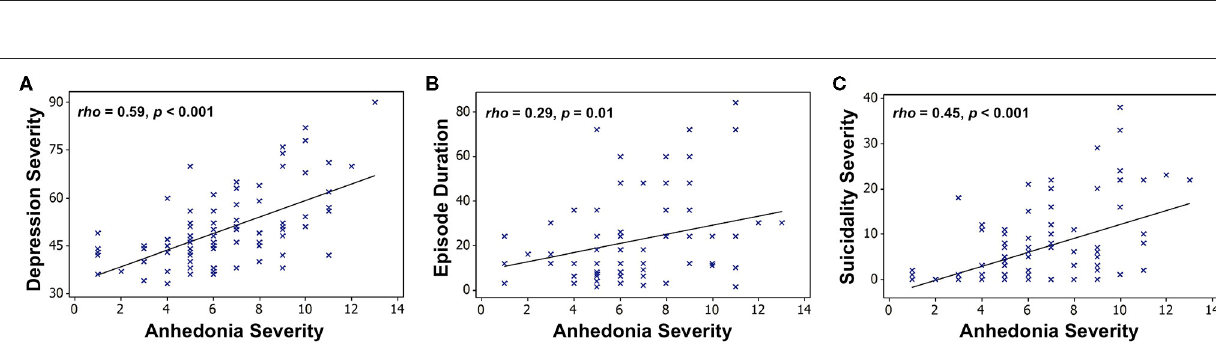
FIGURE 1 | Distribution of anhedonia scores (derived from 1 CDRS-R and 2 BDI questions, range: 1-13) and irritability scores (derived from 1 CDRS-R and 1 BDI question, range: 1-10) in a sample of 90 depressed adolescents. Histograms superimposed with corresponding normal distributions. Adapted from (54).